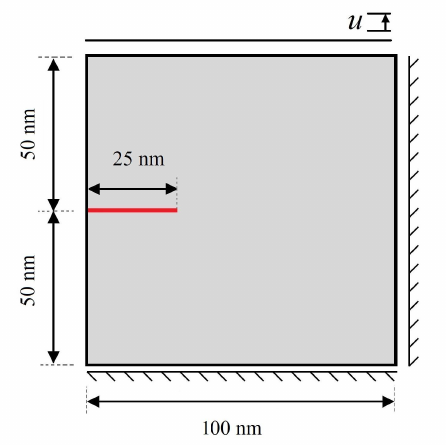
Figure 2. Initial configuration of an austenitic specimen with pre-existing crack under Mode I loading used for validation of the